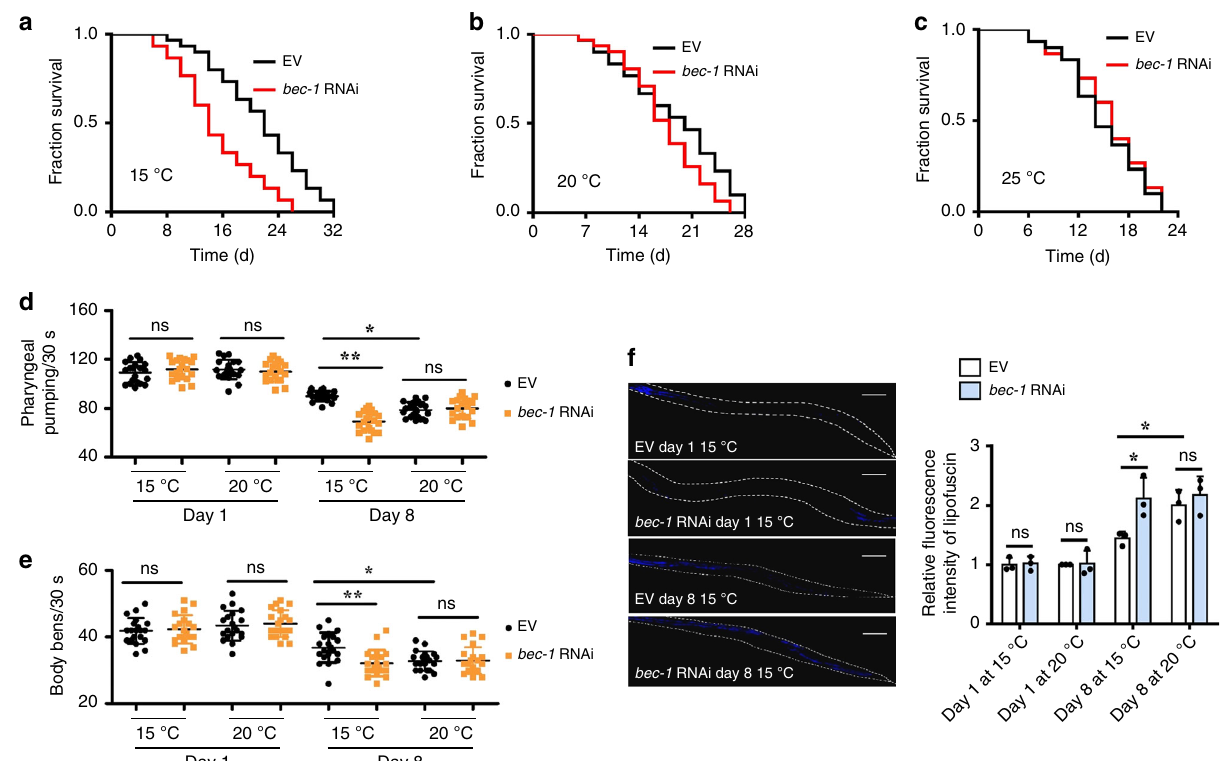
Fig. 2 Autophagy is needed for lifespan extension at low temperature. a – c bec-1 RNAi signi fi cantly reduced lifespan of worms at 15 °C (Log-rank test, P < 0.01 versus EV), but not 20 °C, and 25 °C. EV, empty vector. See Supplementary Data 1 for details. d , e Autophagy is involved in delaying the appearance of the aging markers, including pharyngeal pumping ( d ) and body bending ( e ), in worms at 15 °C, but not 20 °C. These results are means ± SD ( n = 20). Ten worms were examined per experiment. * P < 0.05, 8-day-old worms with EV at 15 °C versus 8-day-old worms with EV at 20 °C; ** P < 0.01, 8-day-old worms with EV at 15 °C versus 8-day-old worms with bec-1 RNAi at 15 °C. ns, not signi fi cant. f Aging marker lipofuscin auto fl uorescence. These results are means ± SD of three independent experiments ( n = 30 – 34 worms per experiment). * P < 0.05, 8-day-old worms with EV at 15 °C versus 8-day-old worms with EV at 20 °C, or 8-day-old worms with bec-1 RNAi at 15 °C. ns, not signi fi cant. P -values ( d – f ) were calculated using a one-way ANOVA followed by a Student-Newman-Keuls test. Scale bars: 100 μ fat-6 was not altered at 15 °C (Supplementary Fig. 7b). Consistent